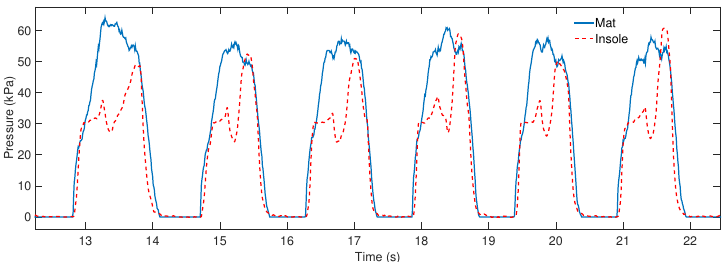
Figure 9. Mat and insole plantar pressure data during six